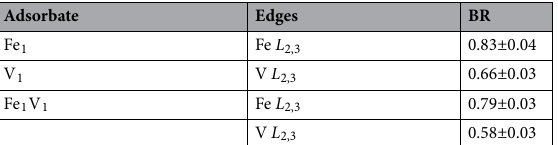
Table 1. Branching ratios of the adsorbates for θ = 0 ◦ calculated from the white line spectra. Values for other incidence angles are omitted, as the branching ratio is found to be isotropic. For the alloy dimer, the branching ratio is shown for both elements separately.